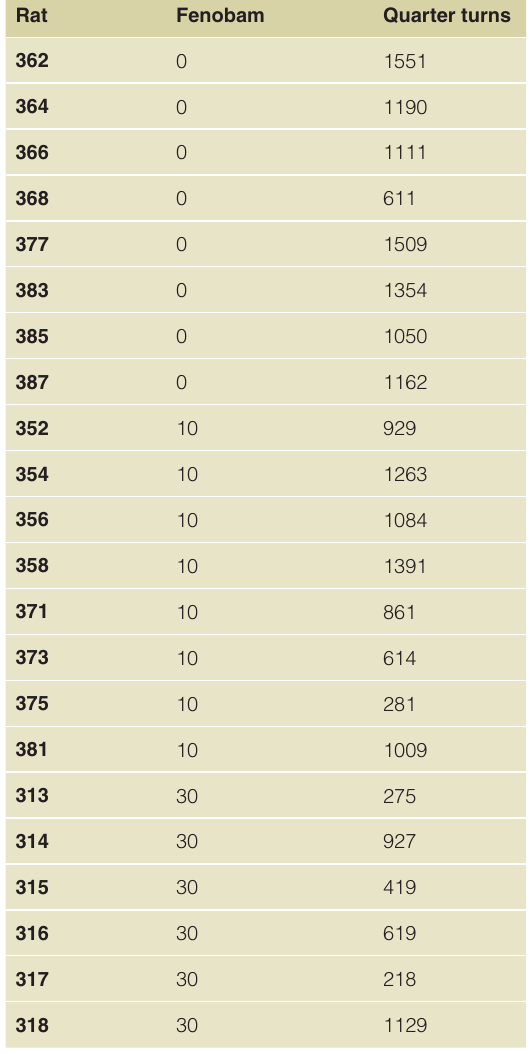
Table S7. Fenobam (0, 10, 30 mg/kg) effects on METH locomotor response (total quarter turns over 90 min) – history of saline injections. In the Day 16 tests using 0.5 mg/kg METH in all groups, rats with a history of chronic saline injections exhibited elevated locomotor behavior, but fenobam pretreatment had no effect.